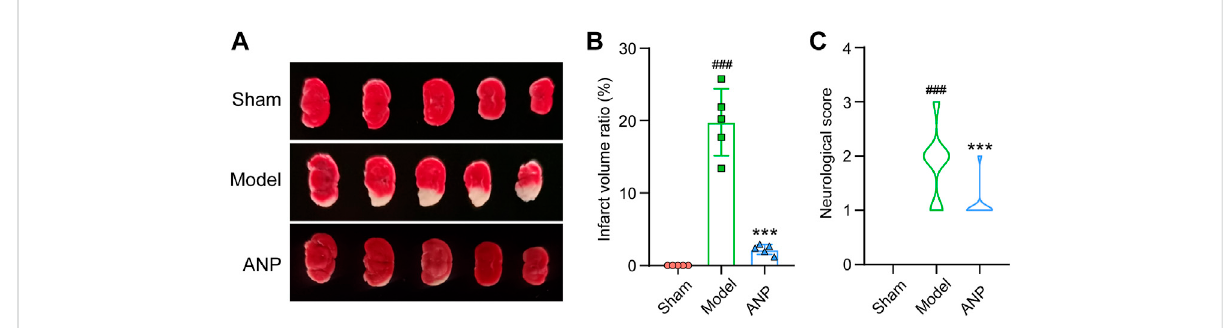
FIGURE 1 ANP reduced the infarct volume ratio and the neurological de fi cit score. (A) The representative images of TTC-staining. (B) The infarct volume ratio ( n = 5). Statistical differences were examined by one-way ANOVA. (C) The neurological score ( n = 32). Statistical differences were examined by one-way ANOVA. ### p < 0.001 compared with the sham group; *** p < 0.001 compared with the model